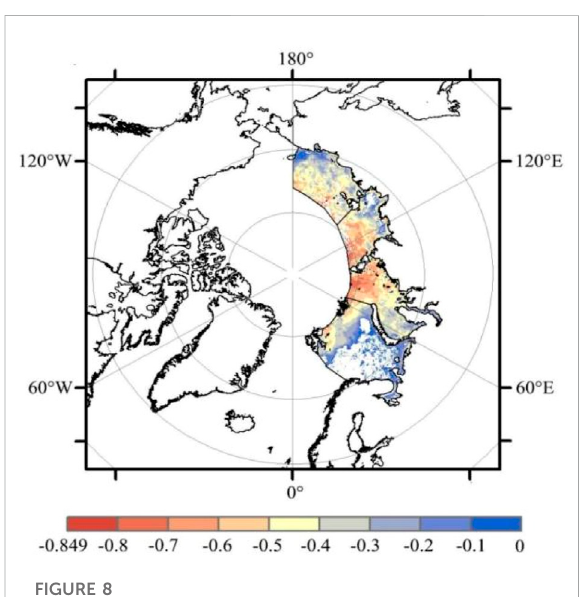
FIGURE 8 The spatial distribution of the correlation between precipitation and SIC in the NEP for May – December for the years 2011 – 2020. (The data for November 2011, December 2011, May 2012, and June 2016 are